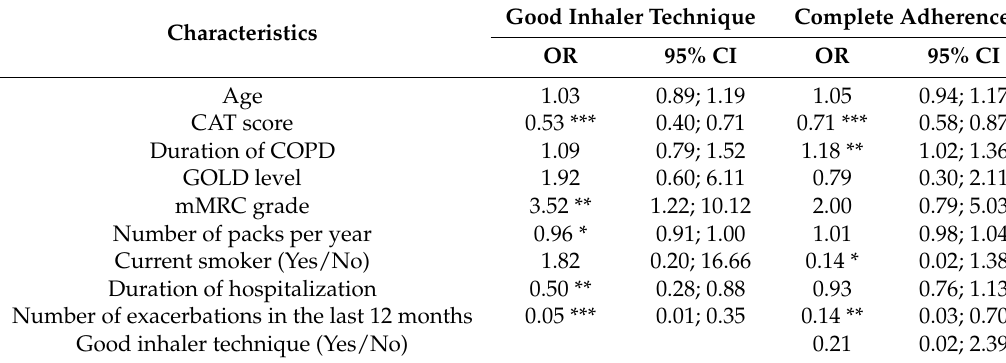
Table 4. Factor associated with inhaler technique and level of